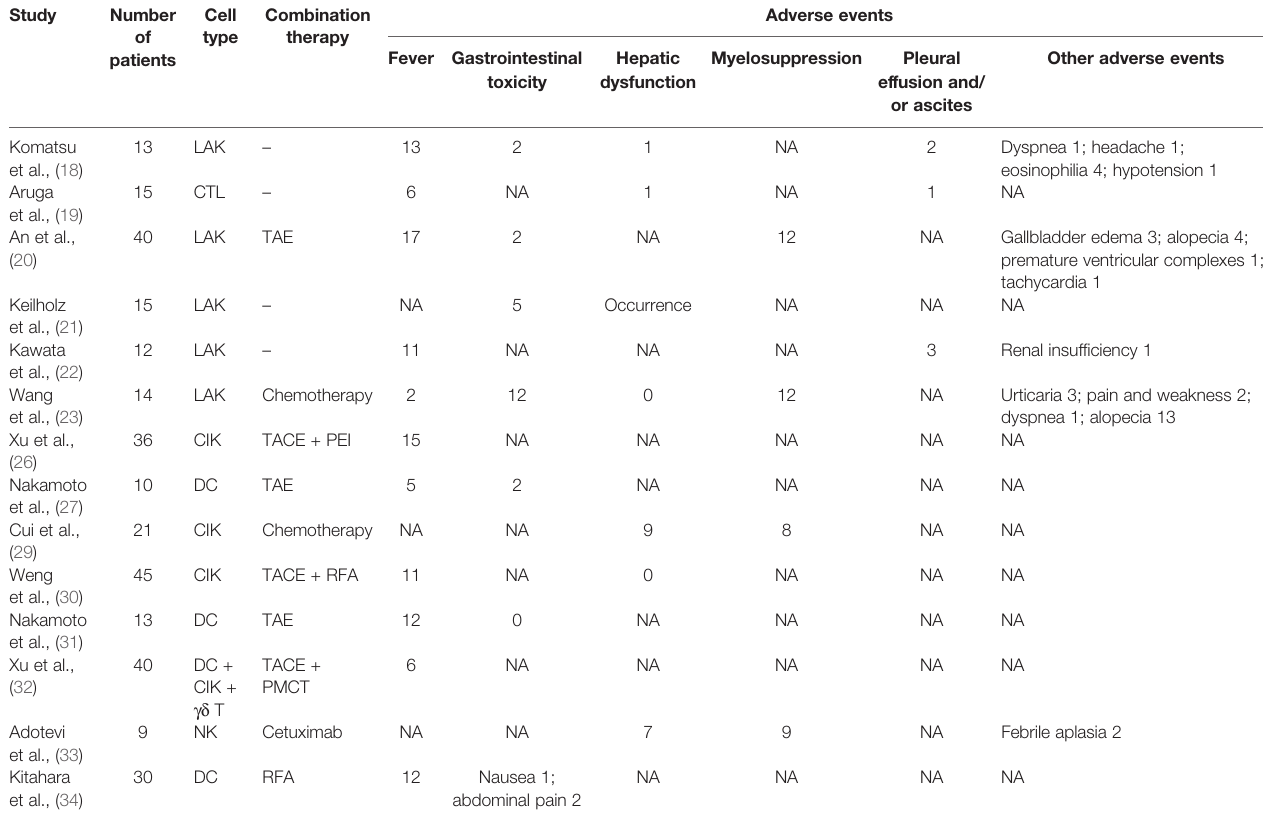
TABLE 4 | Relevant adverse